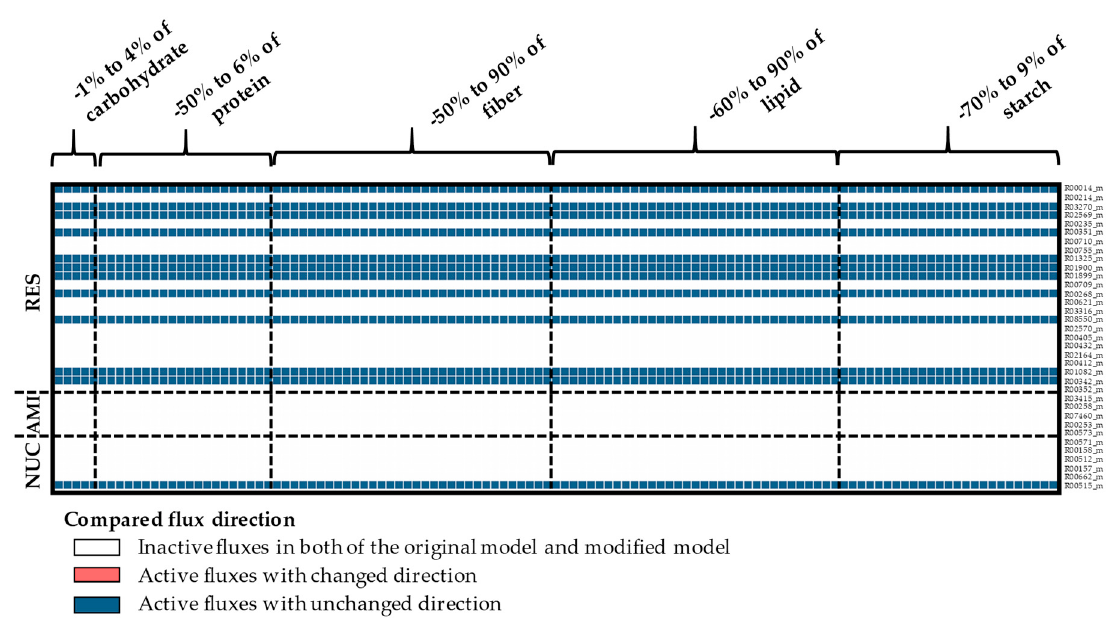
Figure A10. The sensitivity of mitochondrial reaction flux direction to variations in biomass content. Inactive reactions containing zero fluxes are denoted by white-colored grids. Active reactions, non-zero fluxes, with similar flux direction as the original model are denoted by blue grids; while those with dissimilar flux direction (breakpoint) are denoted by red grids. AMI, amino acid biosynthesis pathway; NUC, nucleotide biosynthesis pathway; and RES, respiration pathway.